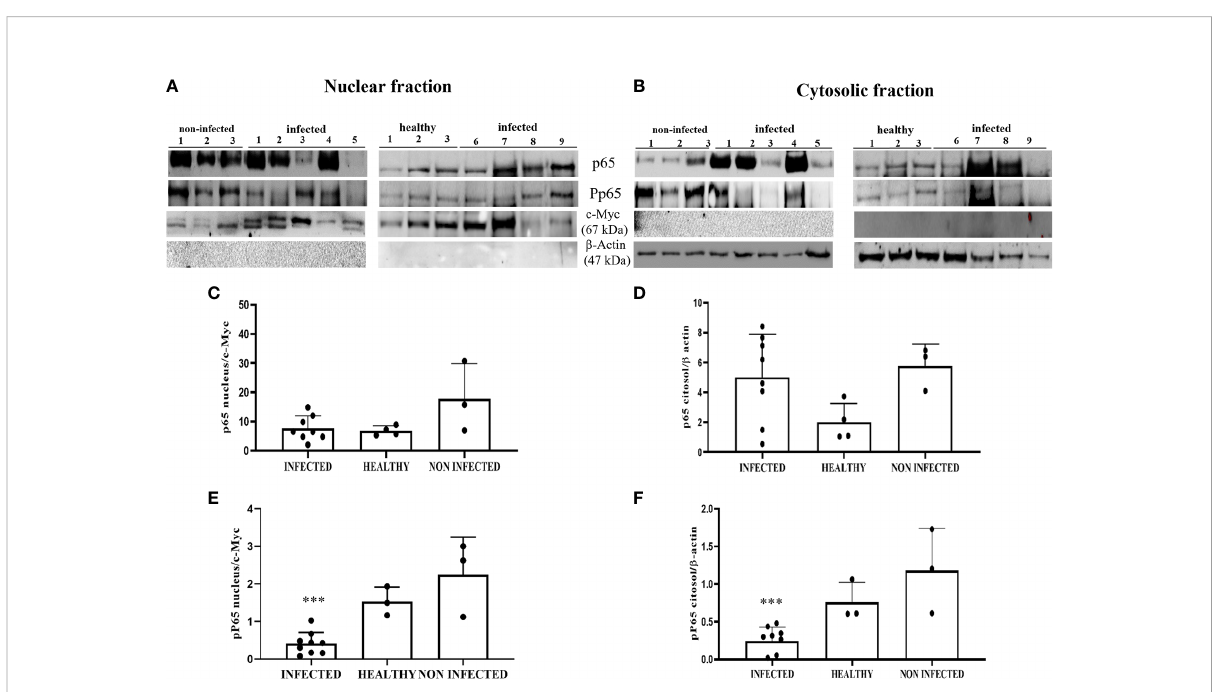
FIGURE 11 (A, B) Nuclear and cytosolic fractions of infected, non-infected, and healthy bladder tissues. The Figure shows western blots of the different fractions of total and phosphorylated p65 (p-p65) proteins. cMyc and b -actin were used to verify selectivity of the extracts and perform densitometric analysis. (C, D) Densitometric analysis of the nuclear and cytosolic fractions of total p65 and (E, F) phosphorylated p65 (p-p65). Signi fi cant differences between BPV-positive and non-infected, healthy nuclear and cytosolic extracts were found for p-p65 (***p ≤ 0.001). Each plot represents the median of three experiments for each